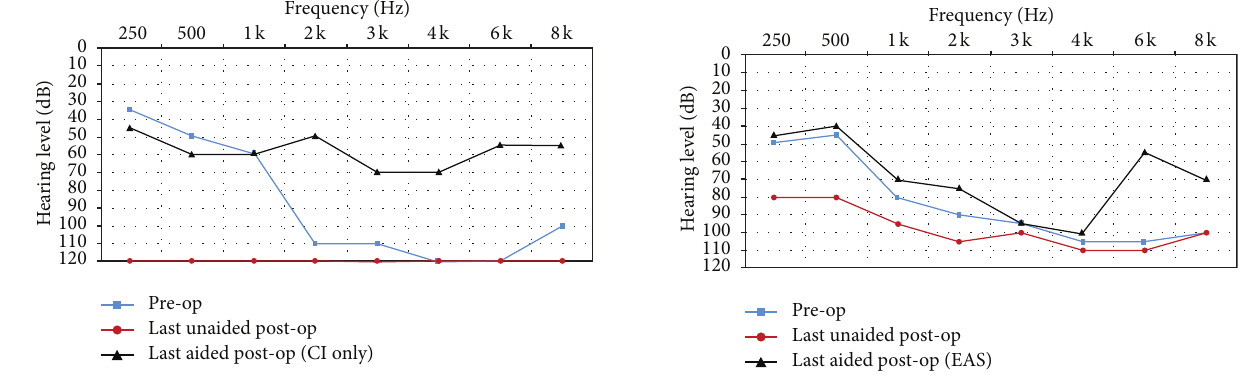
Figure 6: Audiometric results for Subject